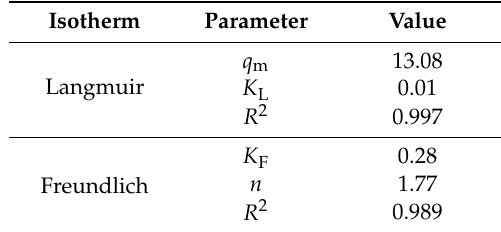
Table 6. Determined parameters of regression coefficients R 2 , K L , and K F of Langmuir and Freundlich isotherms for NaCl electrosorption by using the a-SWCNT (23.58 wt%)-coated RVC electrode as an electrosorption